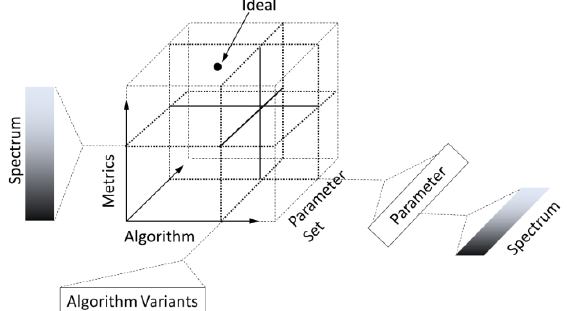
Figure 3 Benchmarking. Many algorithms are compared against many parameter sets, many metrics and reference segmentations (the empirical ideal).